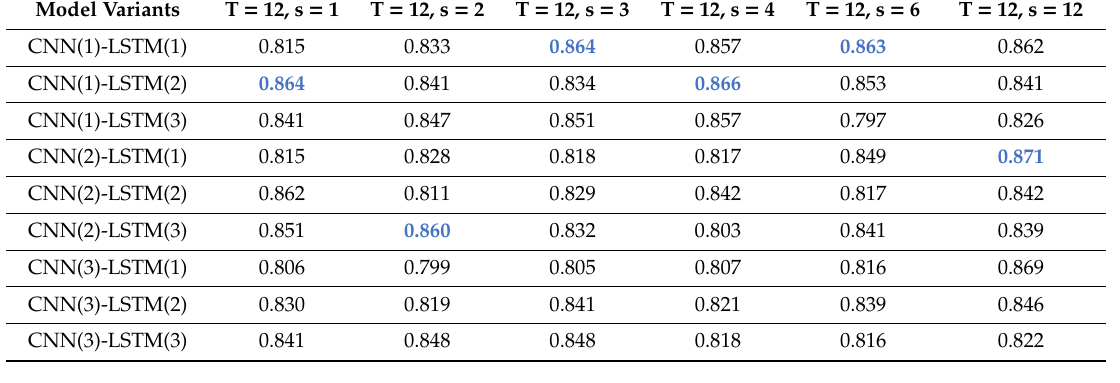
Table 3. The core architecture of the network and the way we use the spatial and temporal context prove to be a powerful approach in spatio-temporal anomaly detection problem. Table 4. OAHII 1 measures of the framework variants with window size T = 12 and di ff erent sliding step sizes s = 1, 2, 3, 4, 6, 12.